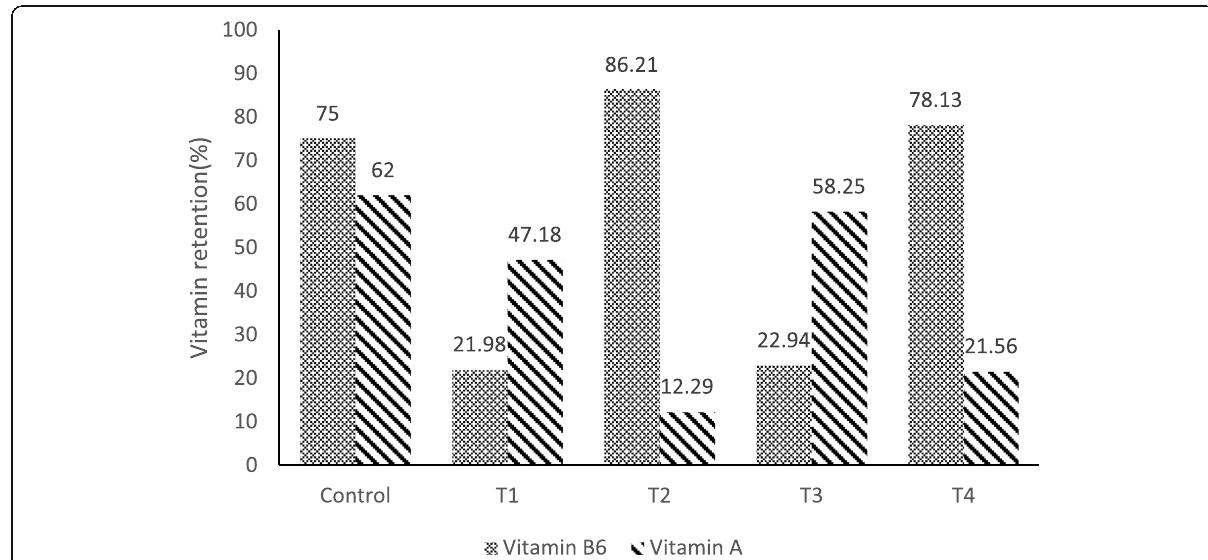
Fig. 3 The vitamin retention percent of extruded products as compared to raw blends. Control: plain extruded product. T1, T2, T3 and T4: extruded corn products fortified with 3% (w/w) of laurel, turmeric, ginger and mixture formula contains 3% of the three herbs ’